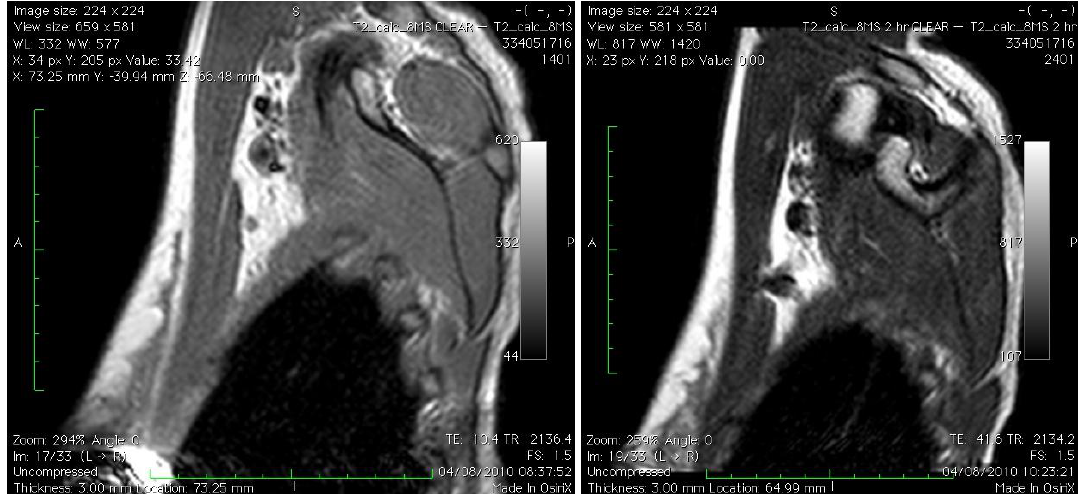
Figure 1. Left panel: right axilla pre-Endorem injection on MRI scans; right panel: SLN easily identified 120 minutes post-Endorem injection